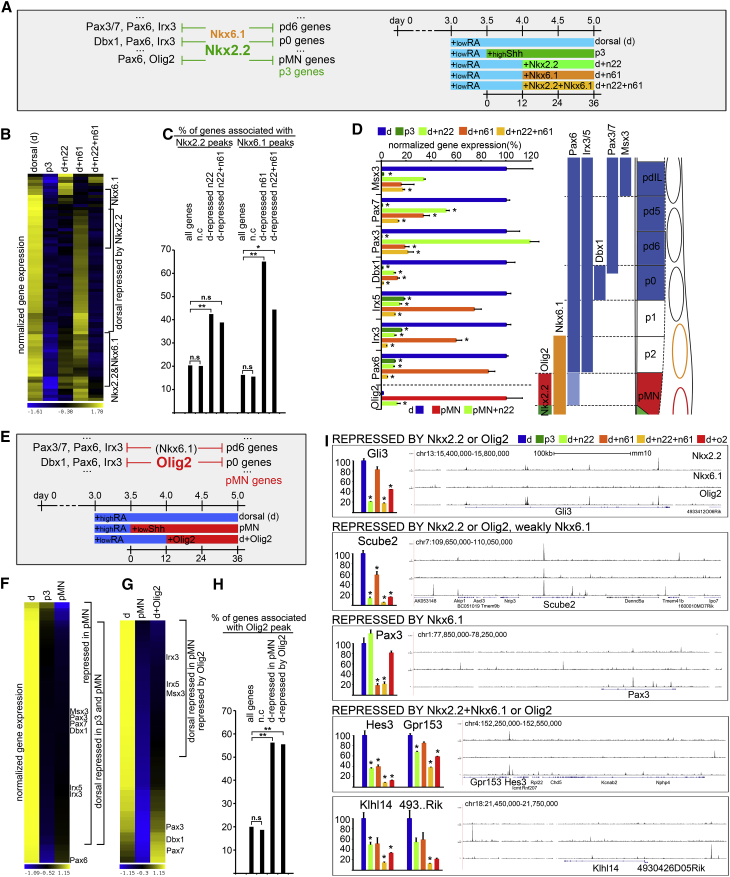
Nkx2.2, Nkx6.1, and Olig2 Repress Genes of Non-adjacent Progenitors(A–D) Nkx2.2 together with Nkx6.1 repress non-adjacent dorsal identities. (A) Schematic of the experimental rationale. To test the activity of Nkx2.2 and Nkx6.1 in non-adjacent progenitor domains, ectopic Nkx2.2 (n22), Nkx6.1 (n61), or Nkx2.2 and Nkx6.1 (n22 + n61) were induced in iNPC-D cells and their transcriptomes compared with iNPC-D and iNPC-p3 cells. (B) Analysis of the transcriptomes of iNPC-D cells after ectopic induction of Nkx2.2 and/or Nkx6.1 indicated the repression of subsets of genes normally characteristic of dorsal progenitors. Genes characteristic of dorsal progenitors are defined as “dorsal” (blue) in Figure 1D. These were selected using the criteria of higher expression levels in dorsal progenitors compared with p3 and pMN cells at 36 hr. The induction of Nkx2.2 alone was sufficient to repress many of these genes; induction of Nkx6.1 repressed a smaller, partially overlapping subset of genes; the combination of Nkx2.2 and Nkx6.1 repressed the majority of iNPC-D-specific genes. See also Table S1, sheet 3B. (C) ChIP-seq data indicate that binding of Nkx2.2 and Nkx6.1 is enriched next to many of the iNPC-D genes repressed by Nkx2.2 and/or Nkx6.1 compared with genes that are not differentially expressed in neural progenitors. ∗∗p(χ2) < 0.001. ∗p(χ2) < 0.01. n.s, non-significant. (D) Analysis of a subset of NP-TFs specific for distinct dorsal domains (see adjacent diagram). Nkx2.2 and/or Nkx6.1 repress these NP-TFs. In some cases both Nkx2.2 and Nkx6.1 repress expression in iNPC-D cells. However, Nkx6.1 but not Nkx2.2 repress Pax3, whereas Nkx2.2 but not Nkx6.1 repress Irx3, Irx5, and Pax6. ∗padj < 0.05.(E–G) Olig2 represses dorsal neural progenitor genes in pMN cells. (E) Schematic of the experimental rationale. To test whether Olig2 contributed to the repression of dorsal genes in pMN progenitors, Olig2 was ectopically induced in iNPC-D cells and the transcriptomes of these cells compared with iNPC-pMN progenitors. (F) Heatmap comparing the transcriptomes of iNPC-D, iNPC-pMN, and iNPC-p3 cells. Most of the dorsal genes that are repressed in p3 cells are also repressed in pMN progenitors. See also Table S1, sheet 3F. (G) Comparison of the transcriptomes of iNPC-D and iNPC-pMN with iNPC-D in which Olig2 had been induced. Olig2 is sufficient to downregulate 56% of the dorsal genes normally repressed in pMN at 36 hr. See also Table S1, sheet 3G.(H) ChIP-seq analysis confirms that Olig2 binds next to 56% of the dorsal genes downregulated in pMN and repressed by Olig2. ∗∗p(χ2) < 0.001. n.s., non-significant.(I) Examples of ChIP-seq tracks for Nkx2.2 (top), Nkx6.1 (middle), and Olig2 (bottom) for the Nkx2.2 and/or Nkx6.1 and/or Olig2 repressed genes. Nkx2.2 and Olig2 bind to multiple intronic CREs of Gli3. Nkx2.2, Olig2, and Nkx6.1 bind to intronic CRE of Scube2. Nkx6.1 binds two intergenic enhancers to repress Pax3. Two clusters of genes repressed cooperatively by Nkx2.2 and Nkx6.1 are bound by either Nkx2.2 (Hes3 and Gpr153) or Nkx6.1 (Klhl14 and 4930426D05Rik) in their vicinity, whereas the other NP-TFs bind further away, separated by several genes that are either not expressed or not differentially regulated in neural progenitors. Thus, genes repressed strongly by Nkx2.2 and weakly by Nkx6.1 seem to be regulated through partially shared CREs (Scube2), whereas genes that require both Nkx2.2 and Nkx6.1 for full repression are regulated through exclusively separate CREs (Table S4). Note also that Nkx2.2 and Olig2 often share regulatory elements controlling expression of dorsal genes. ∗padj < 0.05.